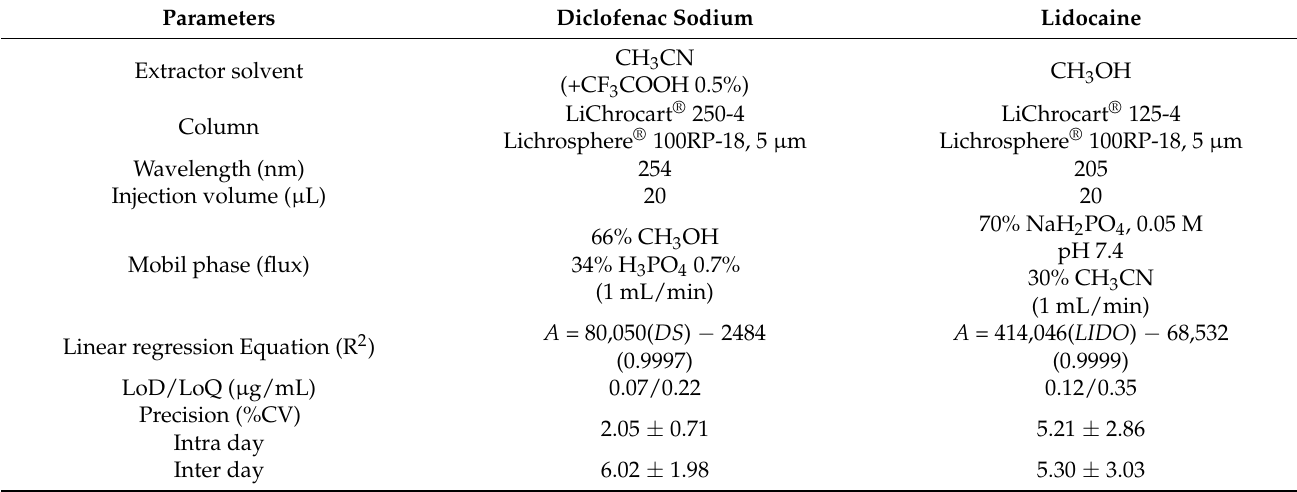
Table 1. HPLC analytical conditions and parameters for diclofenac sodium (DS) and lidocaine (LIDO).